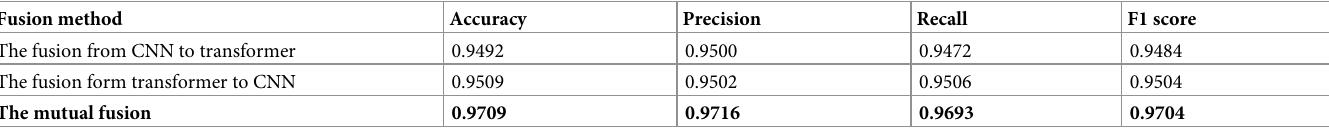
Table 7. Performance comparison of the proposed model with different fusion